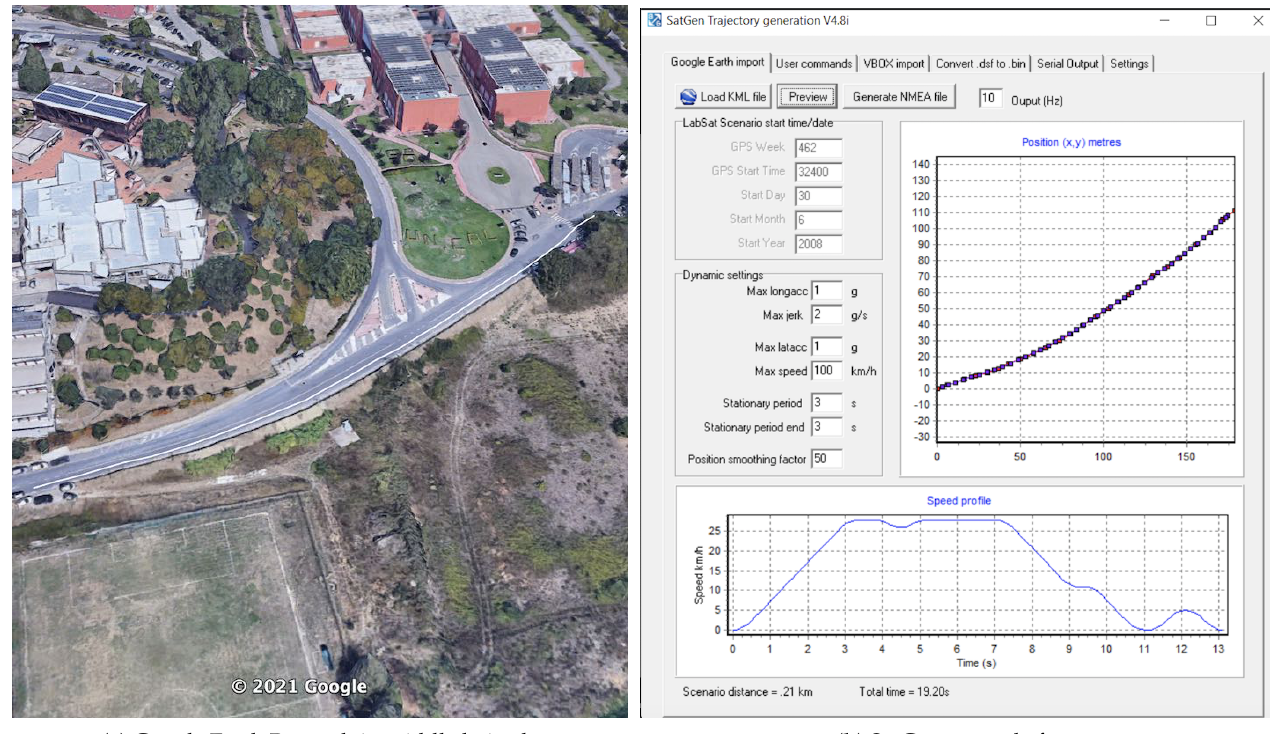
Figure 5. KML example file loaded with SatGen software.